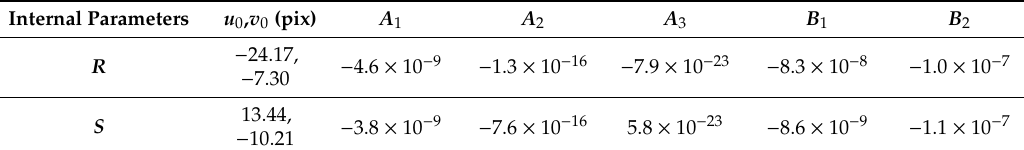
Table 2. Photogrammetry results using 76 images with original size of 2560 × 2048 pixels. Internal Parameters